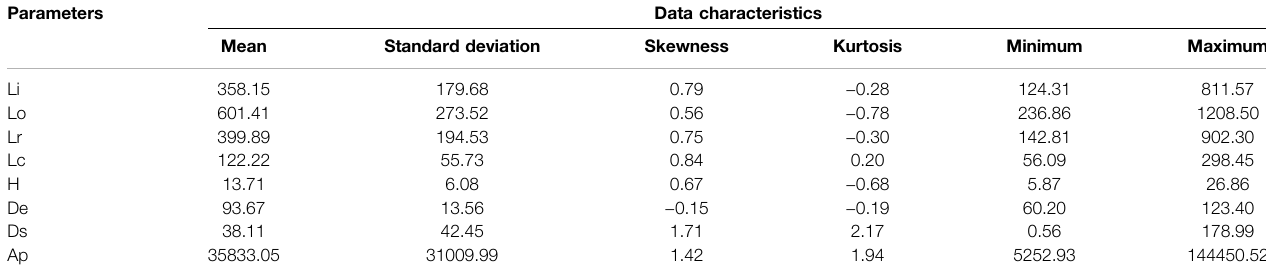
TABLE 1 | Morphological parameter data characteristics of crescent-shaped sand dunes.